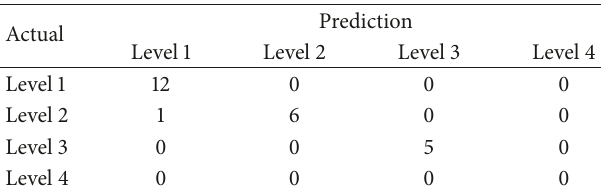
Table 3: Confusion matrix of fall severity level estimation using velocity and kinetic